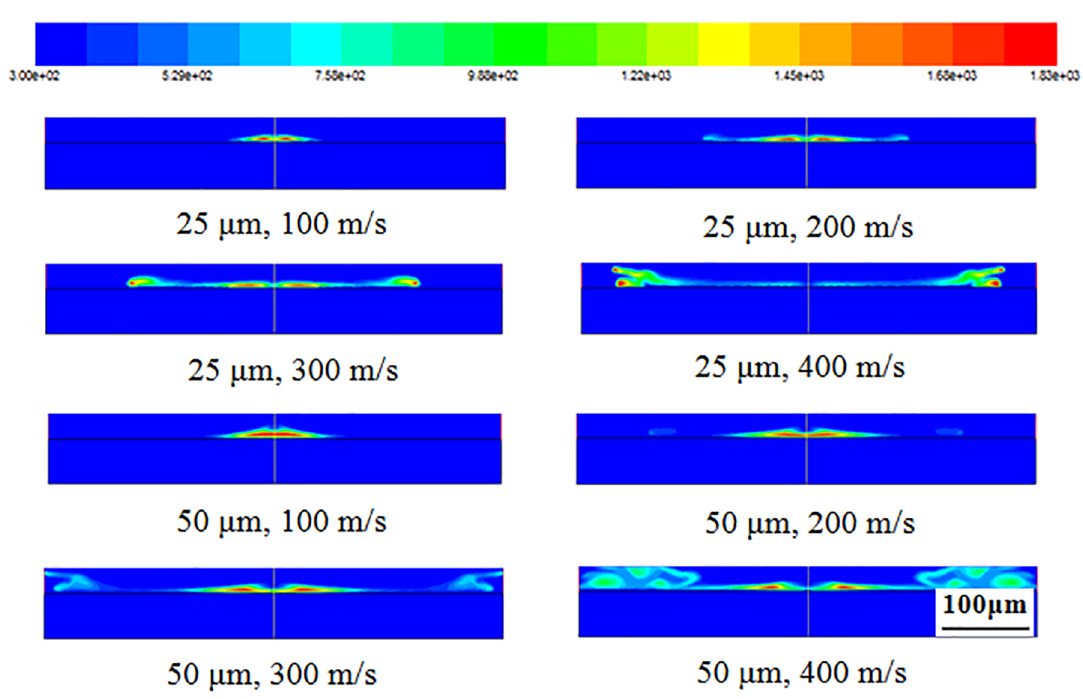
Figure 7. Change of solidification temperature field of TWAS droplet (ø50μm, 100 m/s).